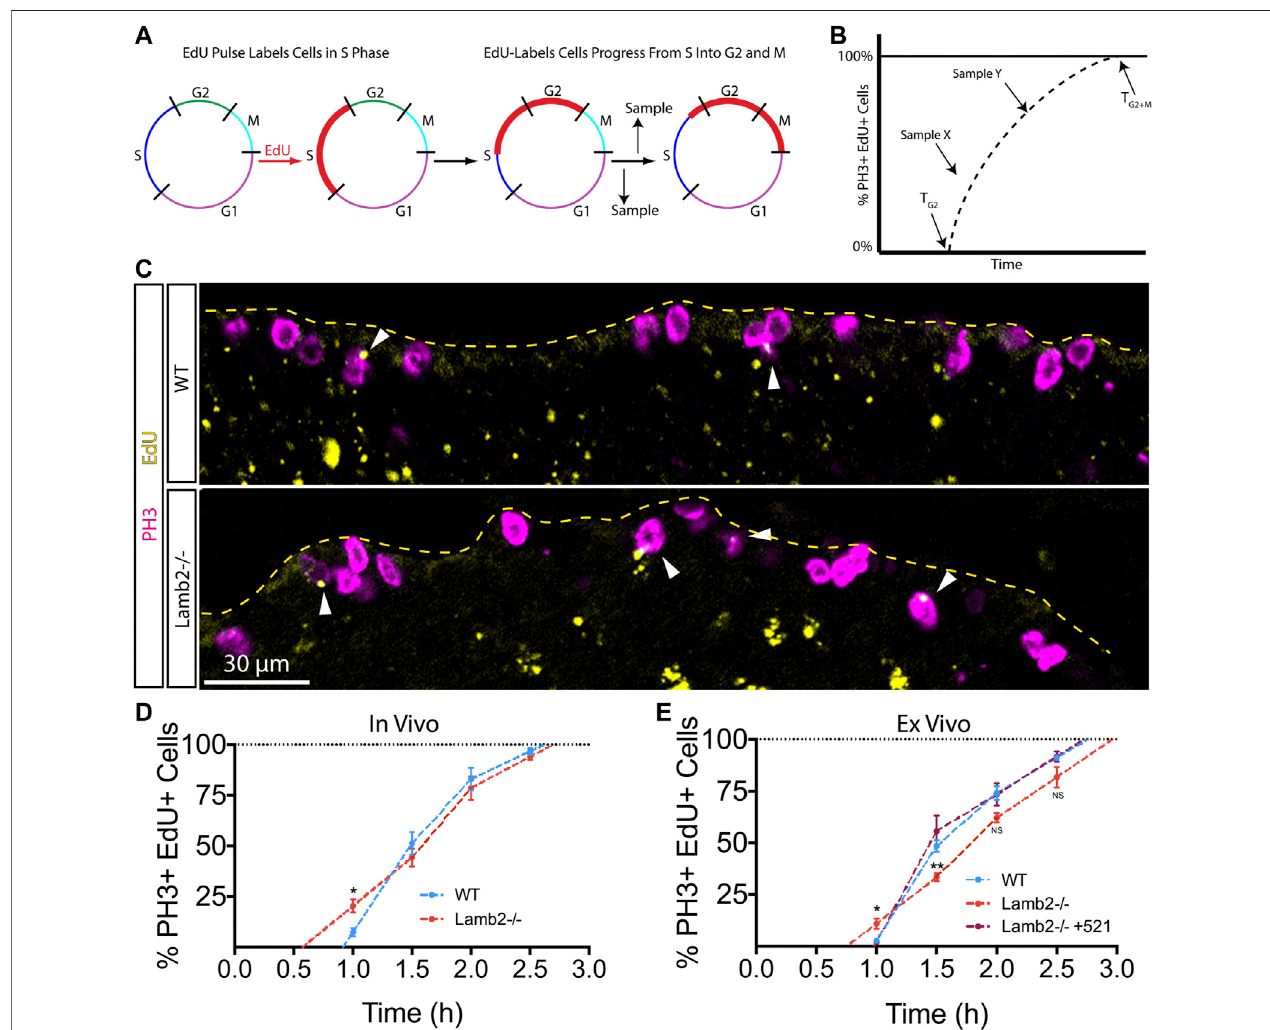
FIGURE 2| RPCG2/Mprogression islaminin-dependent. (A) . Model representation of theprinciples of the percentage of labeled mitosis method. This procedure reliesonabriefEdUexposureofproliferatingcells.TrackingthedynamicsofmitoticentryofEdU+cells(red),allowsdeterminingthetimeittakestogofromStoM-phase. (B) .Modelillustratingthequanti fi cationofthelabeledmitosisexperiments.ThetimeofG2(T G2 )isdeterminedasthetimeneededforEdU+cellstoentermitosis(become PH3+). Time of mitosis (T M ) is calculated as the time required for EdU+/PH3+ population to replace EdU-/PH3+ population. (C) . Representative images of labeled mitosisexperiments performedat P3,and collected1 hafter EdUinjection. Dashedlineindicates theapicalsurfaceoftheretina.ArrowheadsindicateEdU+/PH3+cells, markingRPCs thathavegonefrom S,intoM-phase within1 h. (D) . Invivo percentage oflabeled mitosis saturationgraphsofP3retinas.Lamb2 − / − retinaspresentfaster rate ofM-phase entry and delayedinitialmitotic progression, compared toWT. (E). Ex vivo percentage oflabeled mitosis saturation graphs ofretinal explants. Lamb2 − / − explants present faster rate of M-phase entry and delayed initial mitotic progression, similar to in vivo results. Each data point represents the average of technical and biological experimental replicates ± SEM. Statistical analysis was performed using Student ’ s t-test. * — p ≤ 0.05. ** — p ≤ 0.01. NS — not signi fi cant.